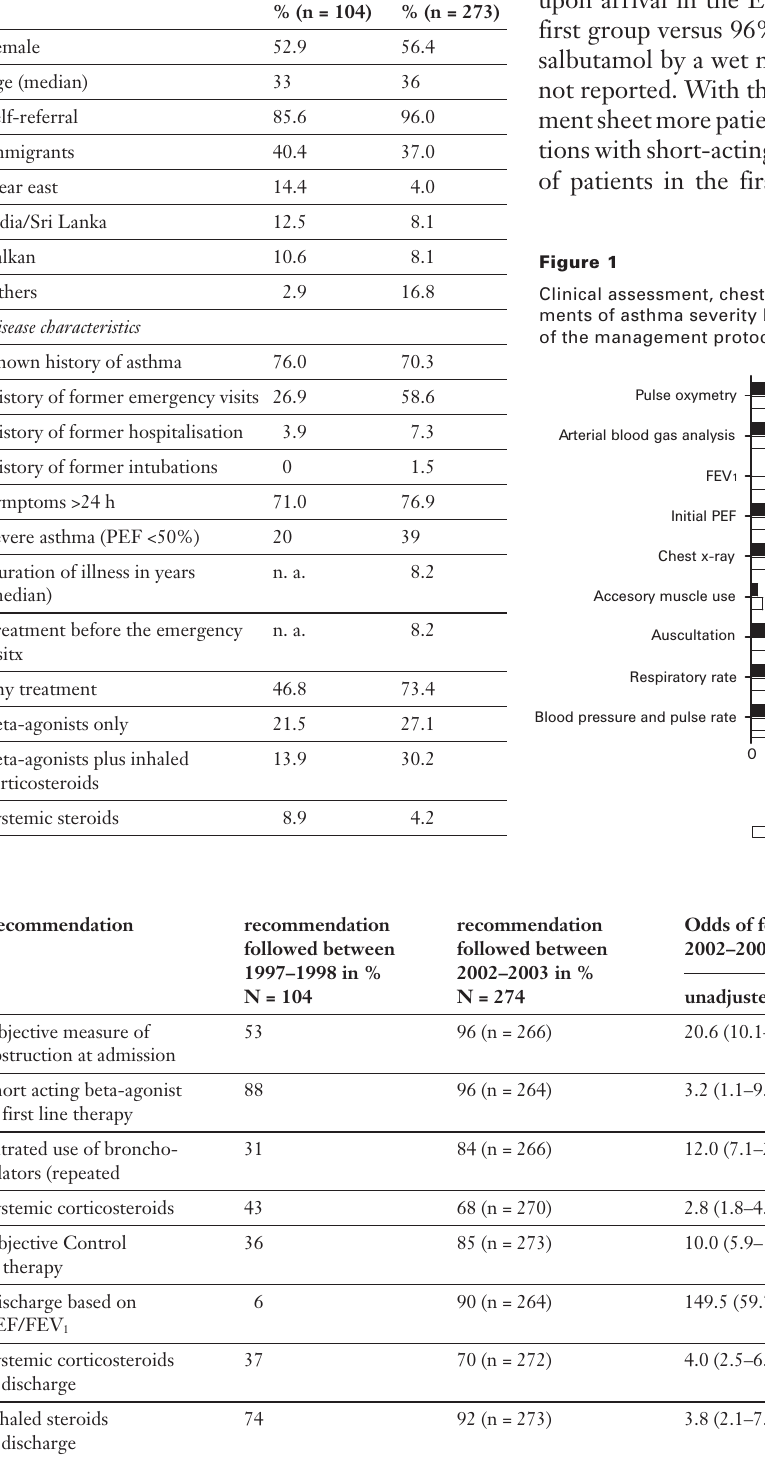
Demographic data and illness character- istics of adults with acute asthma.